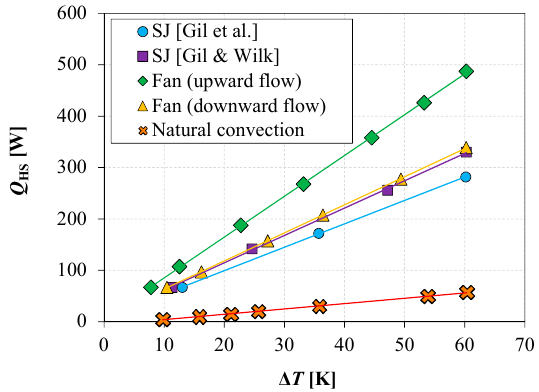
Figure 6. The thermal resistance of the heat sink as a function of ( a ) the power supplied to the cooling device; ( b ) temperature difference ∆ T = ( T b − T ∞ ) at the power of P = 7.0 W. Data from: Gil et al. [27], Gil and Wilk [28].